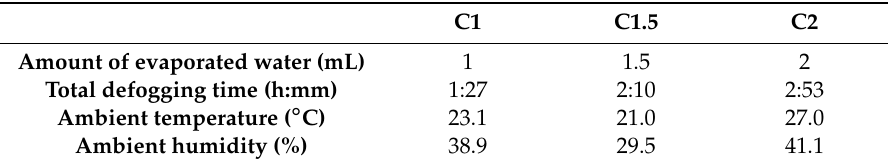
Table 12. Comparison of results achieved from all three experiments.